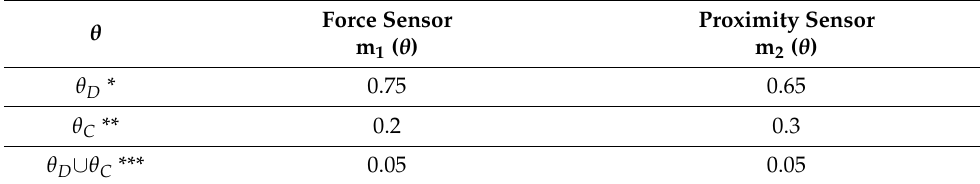
Table 2. Observer experimental data.